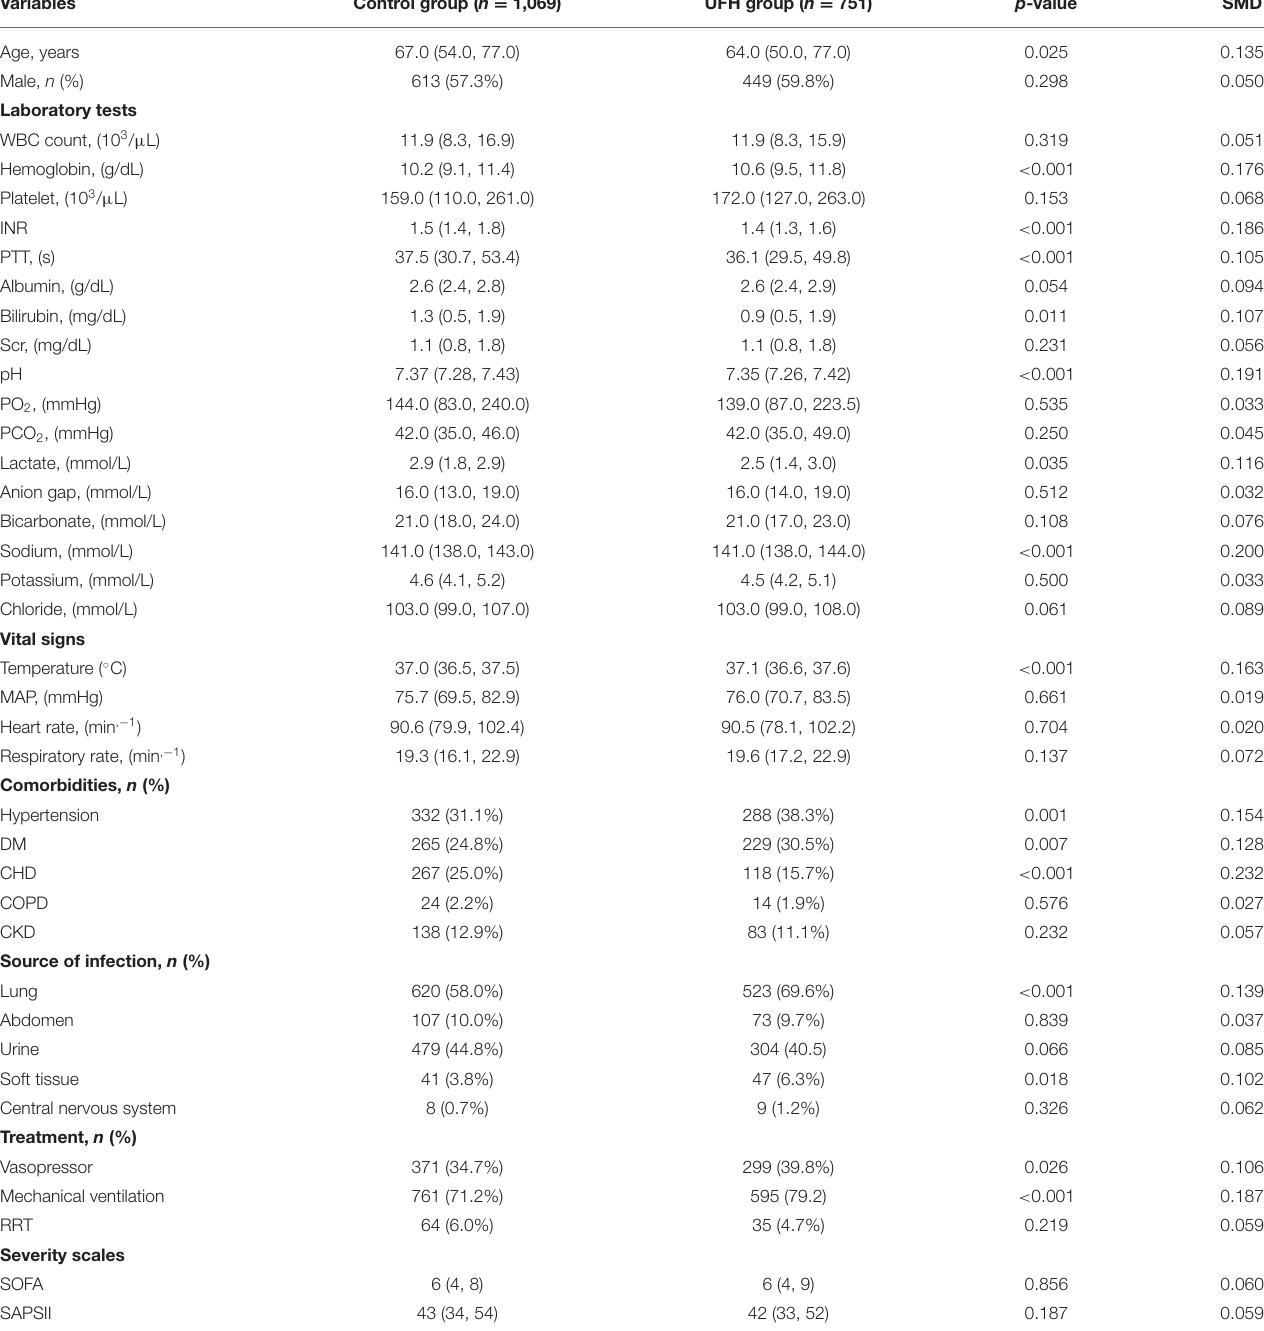
TABLE 1 | Baseline characteristics of the study